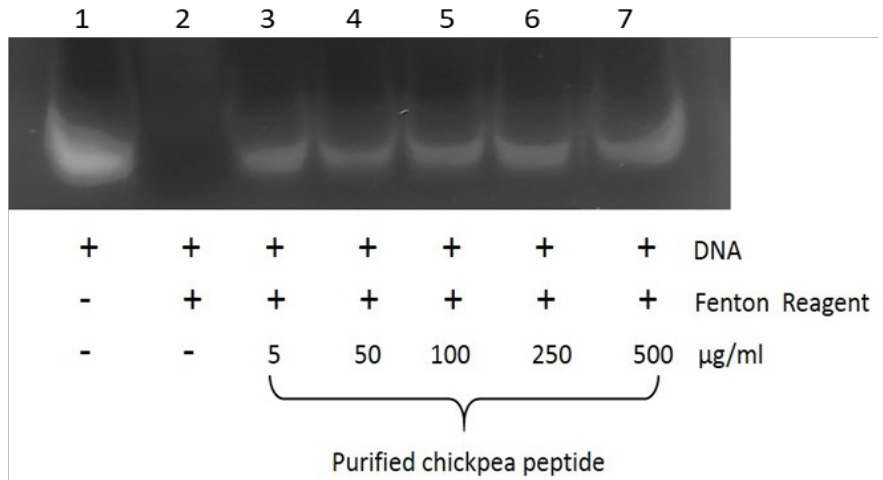
Figure 12. DNA gel electrophoresis depicting effect of chickpea peptide on protection of DNA damage.